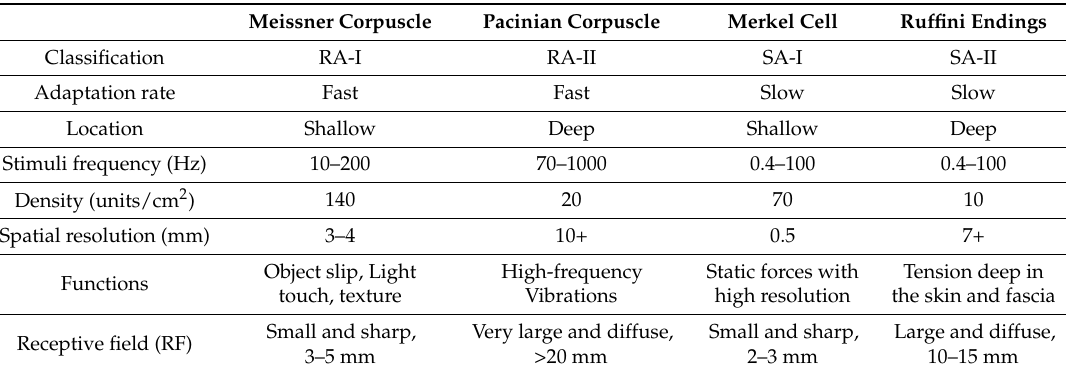
Table 1. Characteristics of the four main mechanoreceptors in human